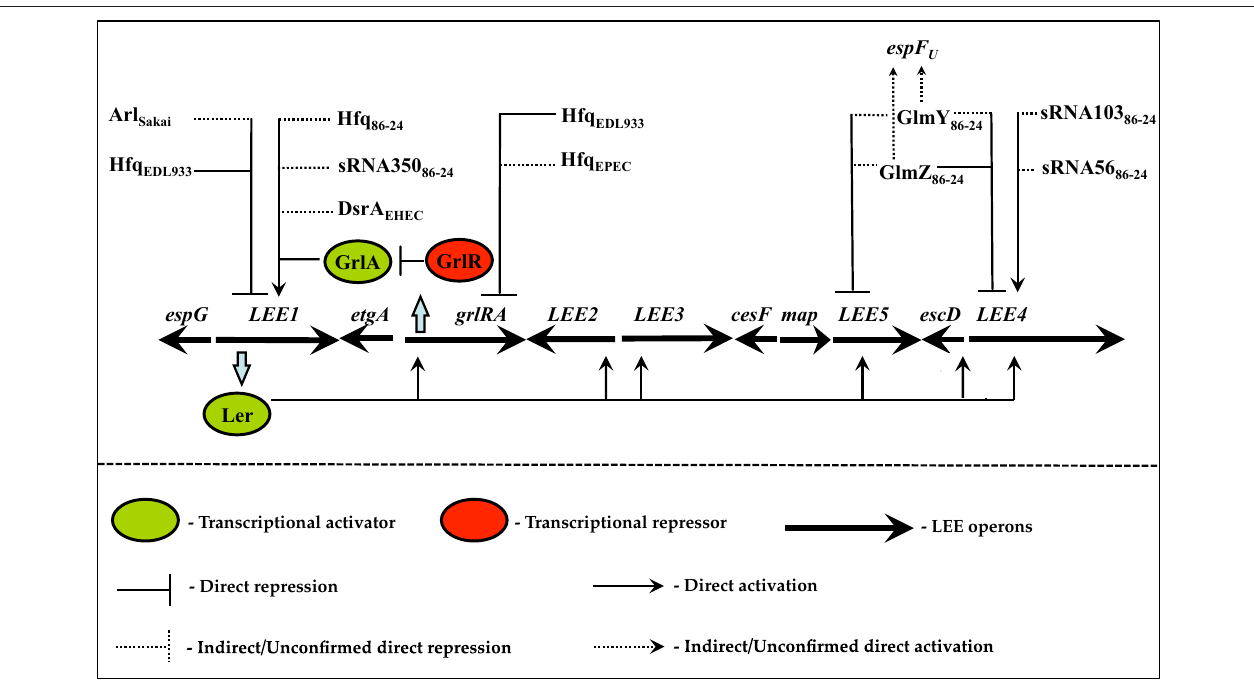
FIGURE 1 | Hfq and sRNA-dependent regulation of the LEE in EHEC and EPEC. The locus of enterocyte effacement (LEE) pathogenicity island includes the multicistronic operons LEE1-5 , the bicistronic operon grlRA , and multiple monocistronic transcription units. In an inducible environment the master regulator Ler orchestrates the synchronous transcriptional activation from the other LEE operons, including grlRA , which culminates with morphogenesis of A/E lesions. GrlA and GrlR participate in a complex positive and negative feedback loop with ler respectively to refine transcription from the LEE. In the EHEC strain EDL933 Hfq represses the LEE by destabilizing the grlRA mRNA as well as by targeting the 5 ′ UTR of ler . In EHEC 86-24 Hfq activates LEE via ler , and multiple trans-encoded sRNAs, integrated at different regulatory checkpoints, are involved in this regulation. These include sRNA350, sRNA103, sRNA56, GlmZ, and GlmY. In the EHEC strain Sakai the cis-encoded sRNA Arl silences LEE by repressing ler . In EPEC, Hfq represses the LEE by targeting grlRA. The figure has been modified from Bhatt et al. (2011).